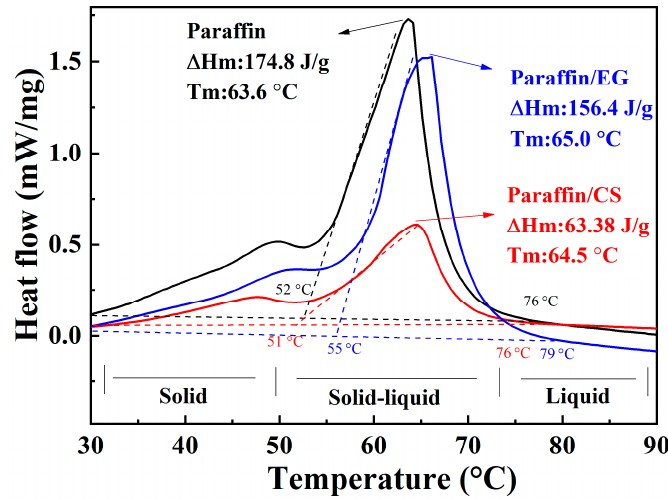
Figure 6. Latent heat of the paraffin and CPCMs.